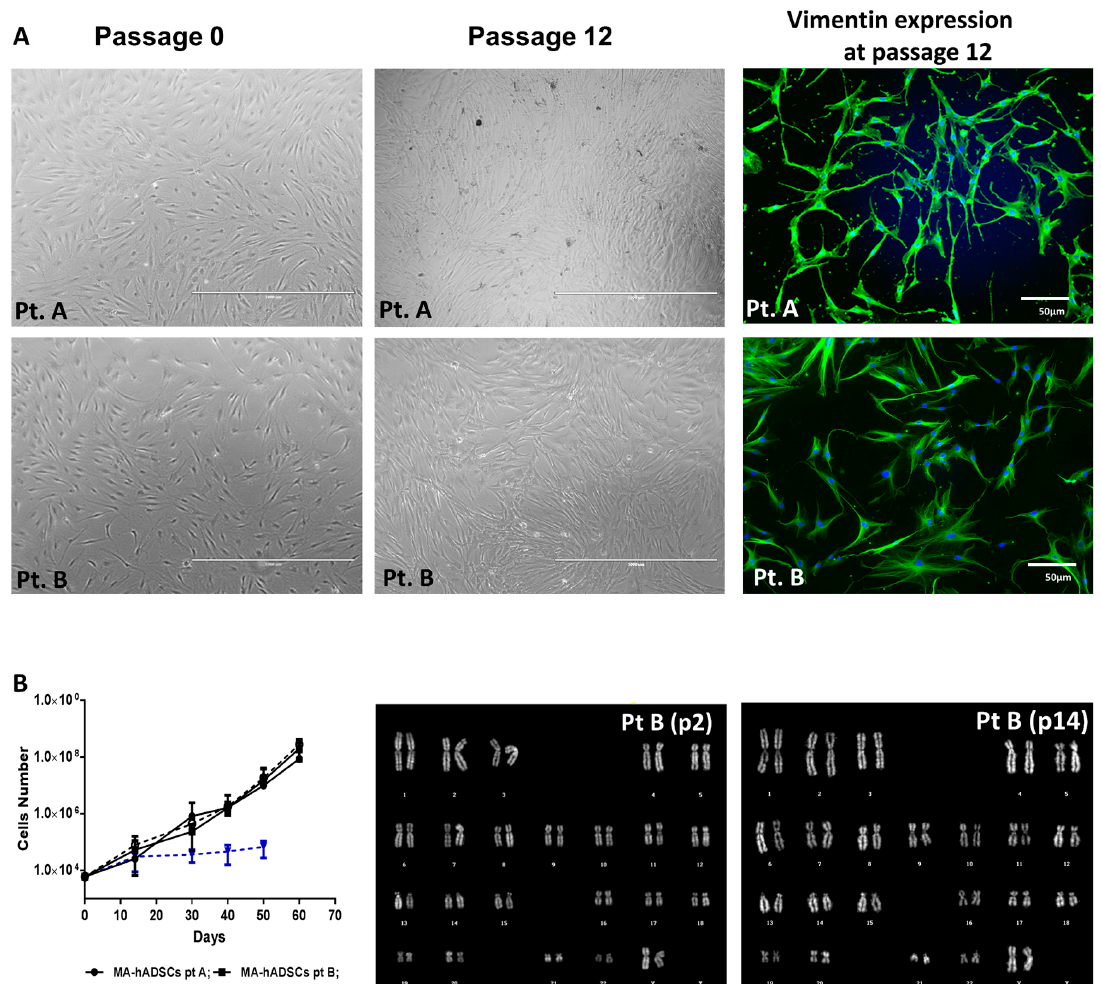
Figure 2. In vitro characterization of human adipose tissue-derived mesenchymal stem cell (hADSC) cultures. ( A ) Live morphology of hADSCs obtained from adipose tissue treated with an orbital shaking force (10 min). Pictures refer to two different cases (Pt. A and Pt. B) that were kept at two different passages in culture (passage 2 and passage 12, respectively). The expression of the mesenchymal marker vimentin was evidenced by immunofluorescence and is shown in green. Nuclei were stained with DAPI in blue; ( B ) Expansion curves of hADSCs derived from activated adipose tissue. Each point of the growth curves represent the mean ± standard error of the mean (SEM) of counts performed in triplicate for cells obtained from three different cases (Pt. A, Pt. B, and Pt. C). The growth curve of hADSCs derived from one LS sample was inserted into the graph as control. Even in this case, counts were performed in triplicate at each time point and are reported as mean ± SEM. Karyotype analyses were performed on an early (passage 2) and a late passage (passage 14) for hADSCs maintained in α MEM supplemented with 15% FBS and antibiotics. These results are representative of the same analyses performed in the other ten cases.